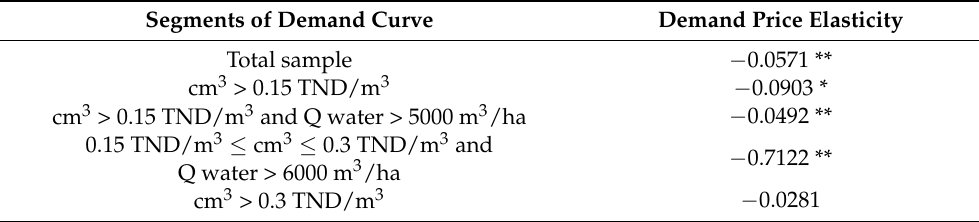
Table 3. The different segments of the irrigation water demand curve and price elasticity. Segments of Demand